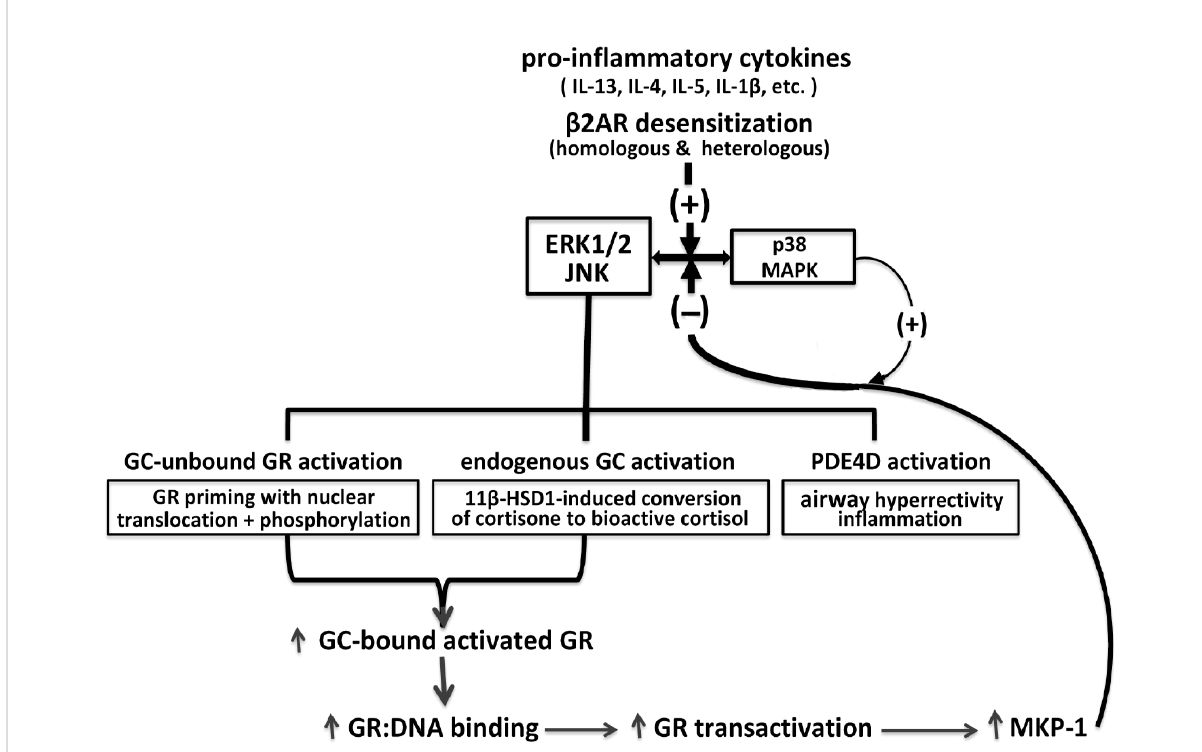
FIGURE 1 Homeostatic glucocorticoid signaling mechanism in pro-asthmatic ASM. Exposure of ASM to pro-in fl ammatory cytokines implicated in asthma and b 2AR desensitization of ASM evokes MAPK activation. The MAPKs, notably involving ERK1/2 and JNK, elicit opposing downstream physiological events, including PDE4D-induced pro-asthmatic airway hyperreactivity and in fl ammation and bronchoprotective endogenous GC signaling. The latter involves 11 b -HSD1-induced upregulated conversion of circulating inert cortisone into bioactive cortisol, and activation of GC-unbound GR “ priming, ” given by nuclear translocation with phosphorylation of the unliganded GR. Together, the latter MAPK-regulated endogenous GC actions are complementary and lead to ampli fi ed GC-bound GR activation resulting in transcriptional upregulation of MKP-1, potentially facilitated by p38 MAPK activity, resulting in feedback inhibition of MAPK signaling. At equilibrium, the MAPK-regulated feed-forward (i.e., pro-asthmatic) and feedback (i.e., GC-mediated bronchoprotective) signaling events dynamically maintain ASM homeostasis under pro-asthmatic